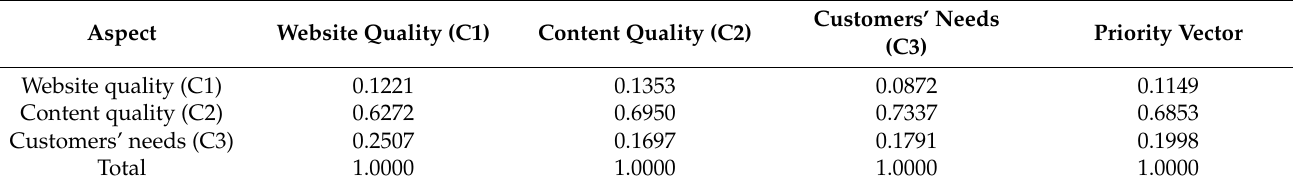
Table 8. The normalized matrix of the G-AHP